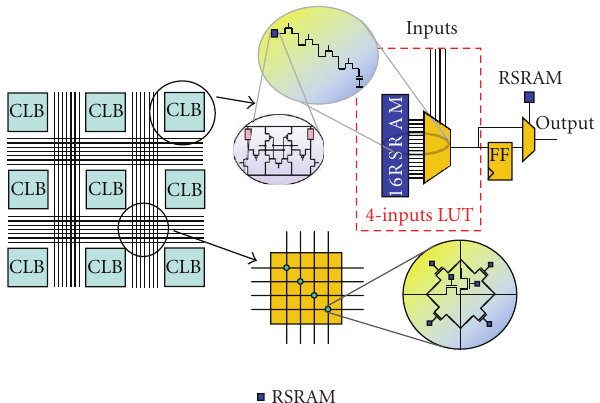
Figure 13: RSRAM-based elementary configurable logic blocks and switch matrix.